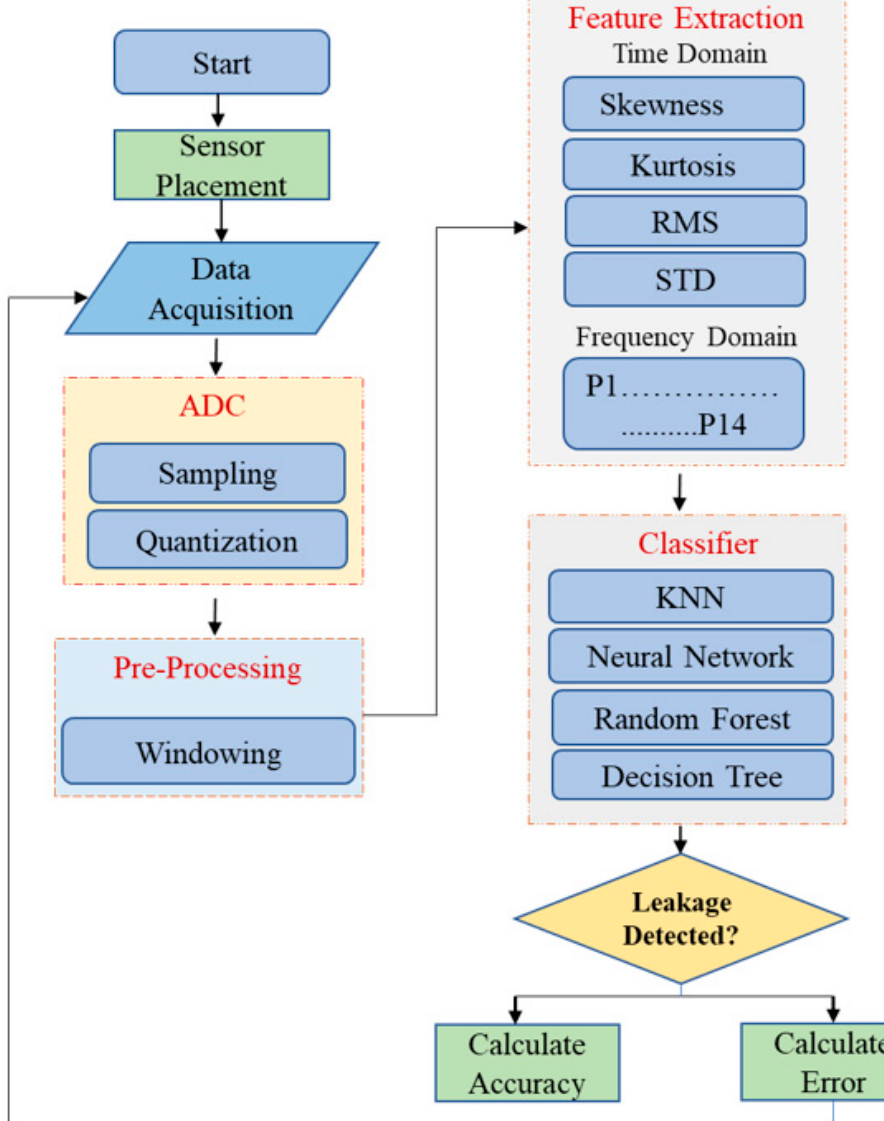
Figure 2. Flowchart of the proposed methodology for leak detection .